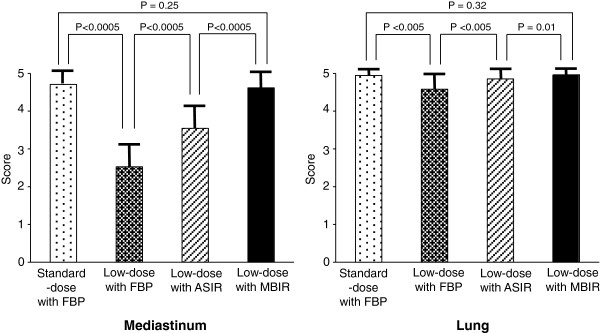
Subjective image noise score. Mediastinal and lung images of standard-dose CT aquired with FBP and low-dose CT with FBP, ASIR, and MBIR. The MBIR algorithm yields significantly improved image noise scores, especially of the mediastinal structures on low-dose chest CT.